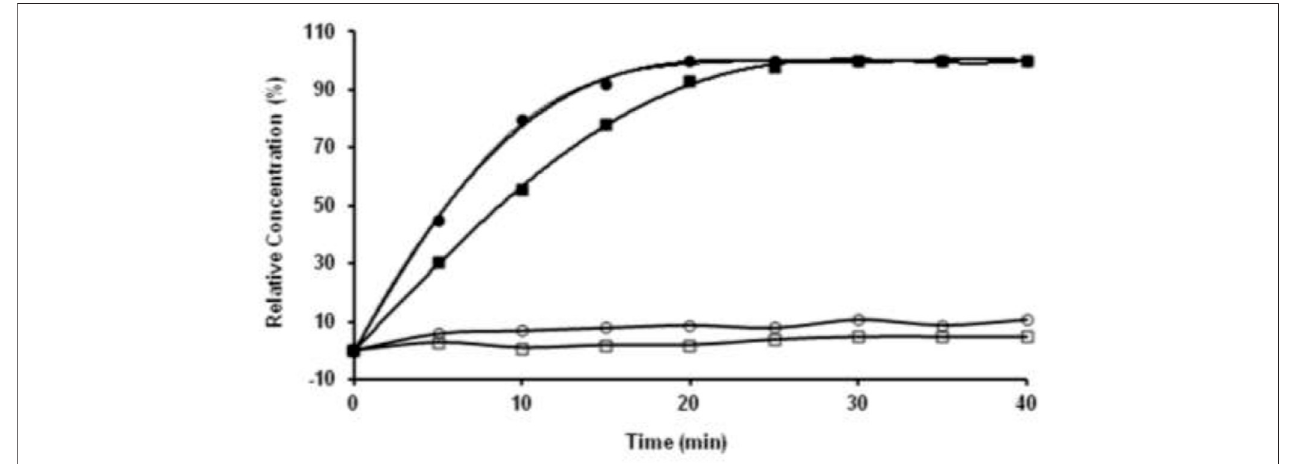
FIGURE 4 | The kinetic hydrolysis time courses of alizarin β - D -galactopyranosides AZ-1 ( ■ ) and AZ-2 ( C ) with β -gal. Absorbance measurements at λ (cid:1) 520 nm following the addition of β -gal (E801A, 3 units) to solutions of AZ-1 , AZ-2 each (5.0 mM) in 1:1 (V/V ′ ) DMSO/PBS (0.1 M, pH (cid:1) 7.4) at 20 – 22 ° C in different time points; The time courses of alizarin β - D -galactopyranosides AZ-1 ( □ ) and AZ-2 ( ○ ) each (5.0 mM) in 1:1 (V/V ′ ) DMSO/PBS (0.1 M, pH (cid:1) 7.4) at 20 – 22 ° C in different time points without β -gal (E801A).